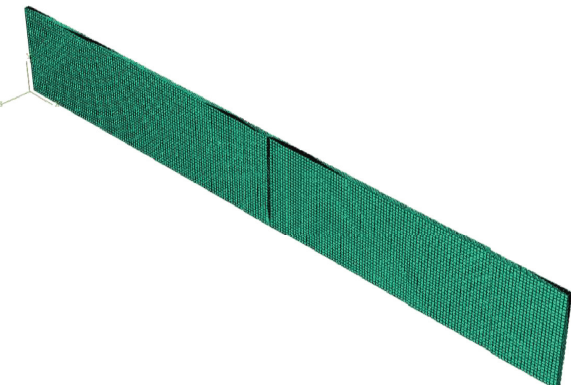
Figure 5: Finite element model for the tensile and load damage of CFRP laminated